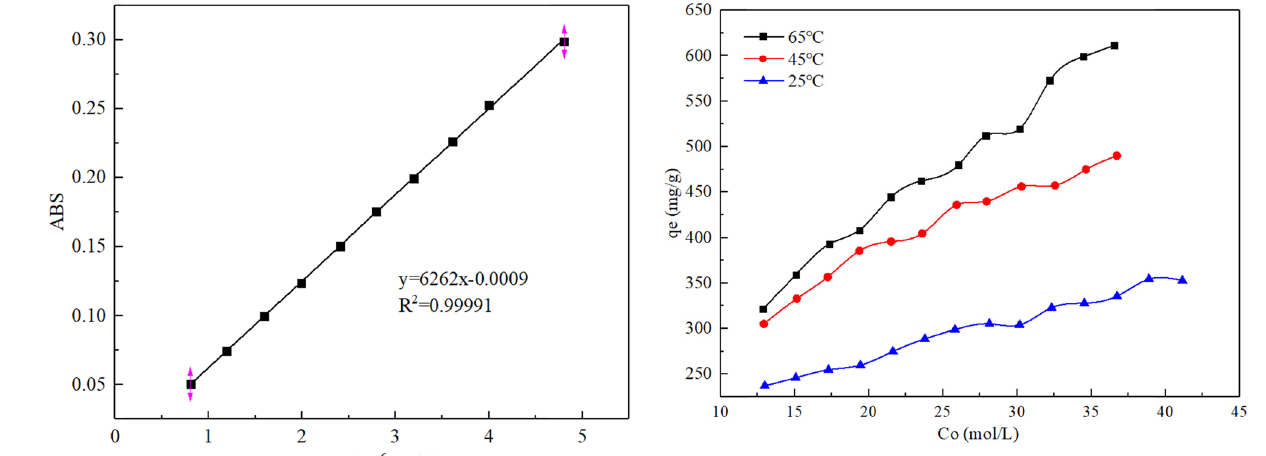
Figure 5: The adsorption isotherm of RH - β - CD.